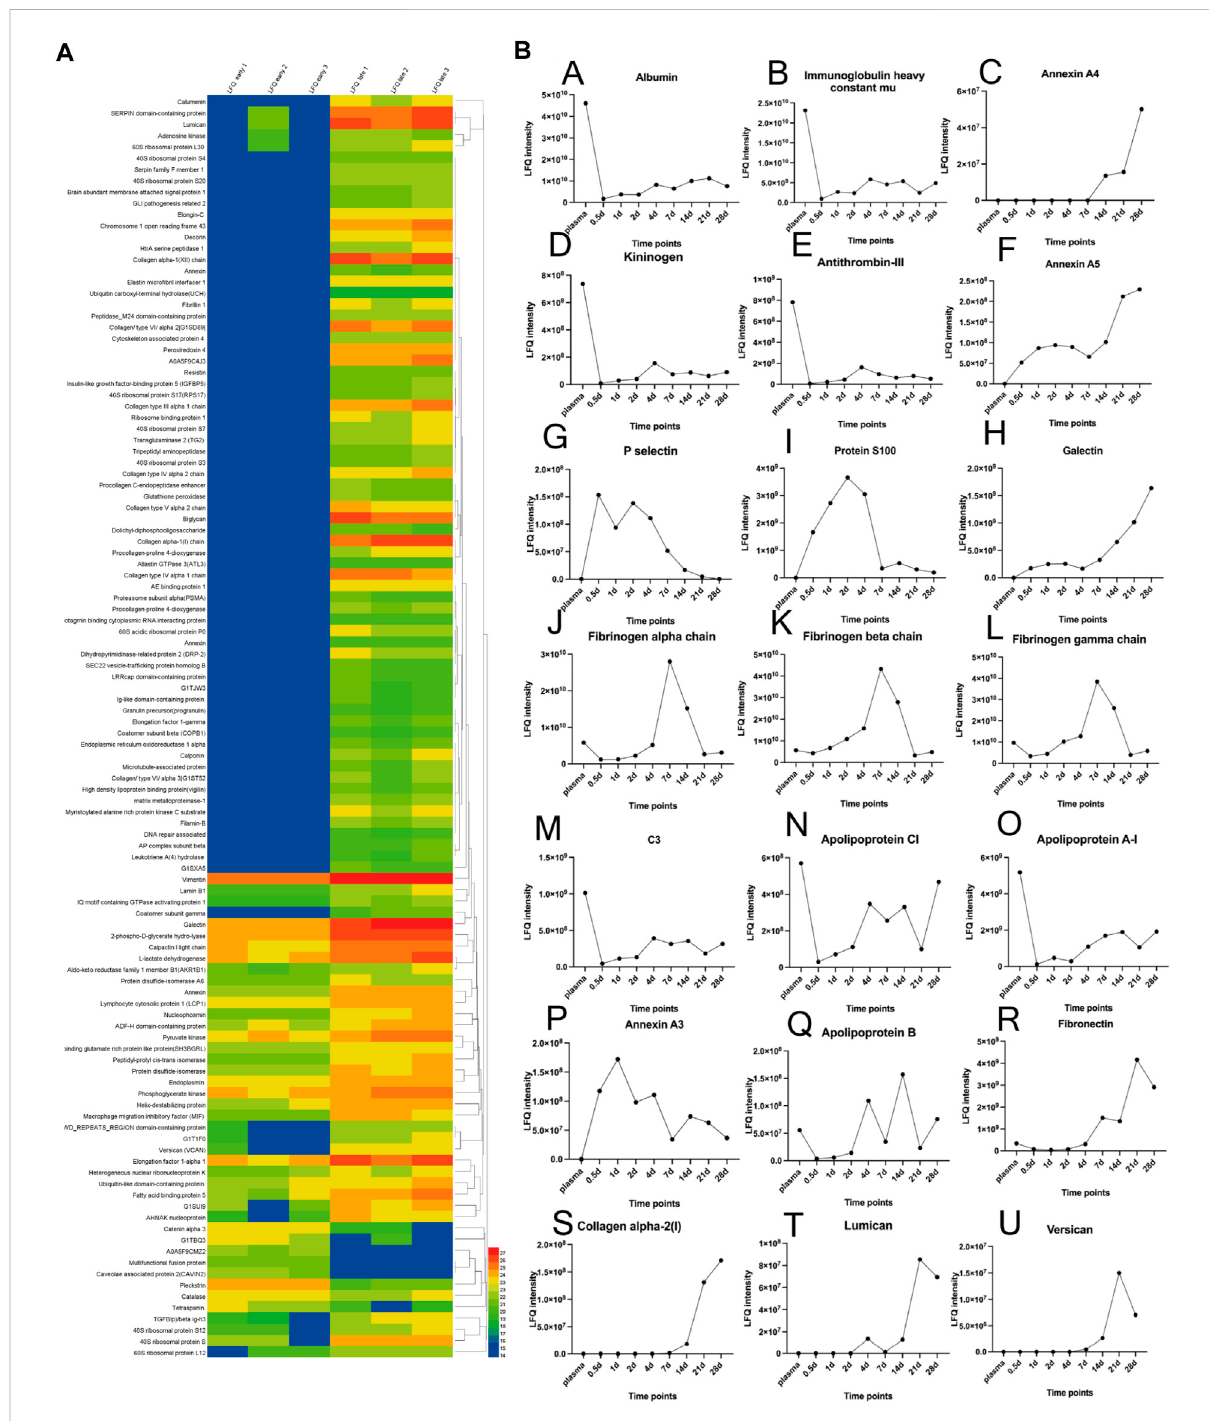
FIGURE 5 (A) :Proteinpro fi leofdifferentialexpressedproteinsinlate-stageneointimacomparedtotheearly.Theheatmapshowedhierarchicalclustering results. The color bars represent the relative quantiles and the color range map indicates the protein expression ratios: blue boxes the down- regulated proteins, red ones the up-regulated proteins. (B) : Relative quantities of 21 proteins over time (including plasma); The (LFQ, label-free